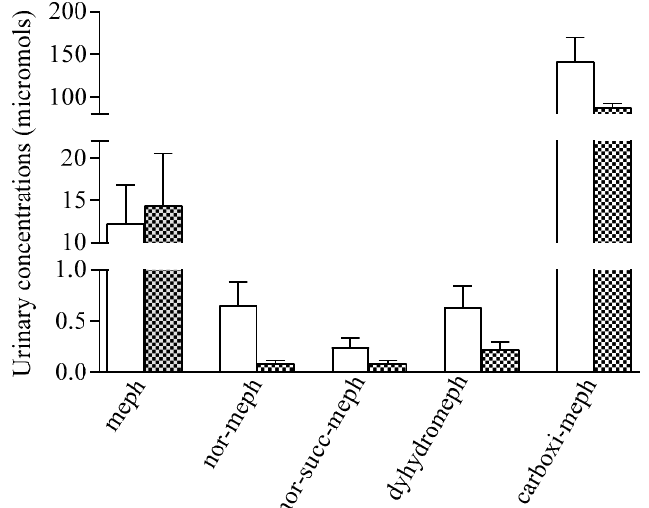
Figure 3. Urinary concentrations of mephedrone after oral and intranasal self-administration (unfilled bar: Oral mephedrone ( n = 5); filled bar: Intranasal mephedrone ( n = 5)).